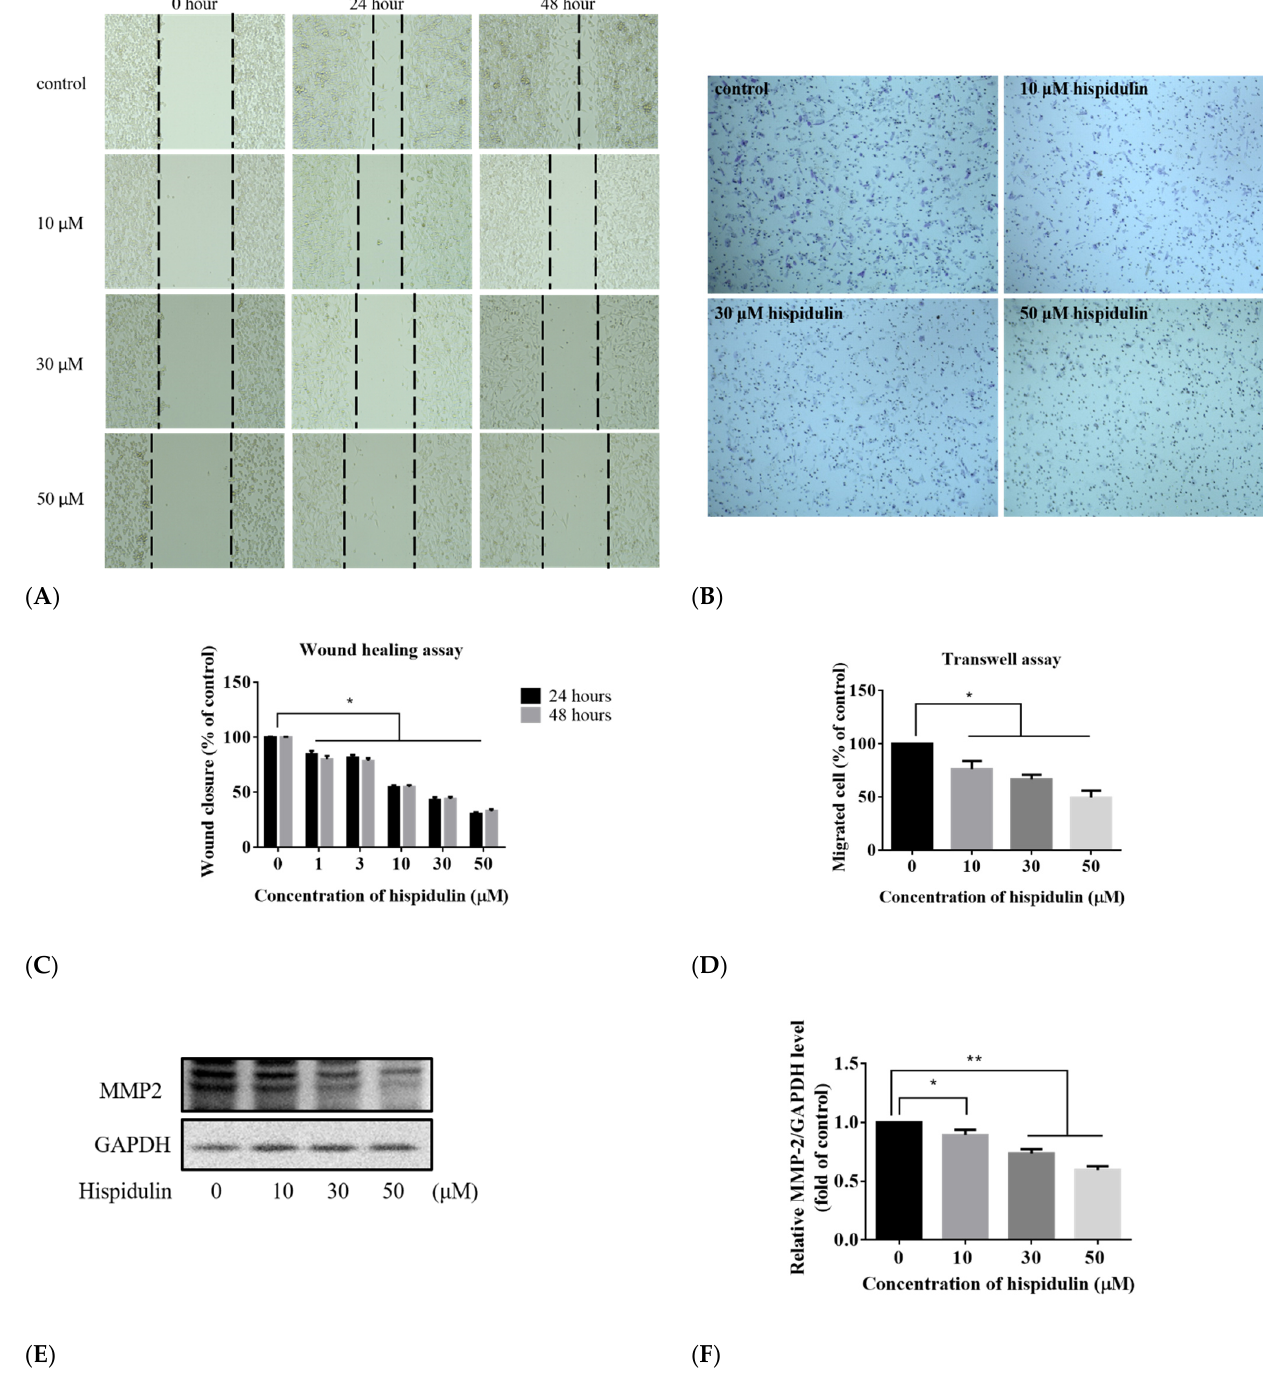
Figure 8. Hispidulin suppressed the motility of the A2058 cells through the wound healing assay and transwell assay ( A , B ). Cell mobility was determined by the wound healing assay. Monolayers of A2058 cells were treated with various concentrations of hispidulin for 24 and 48 h. Cell mobility was determined by the transwell chamber assay. A2058 cells were pretreated with different concentrations of hispidulin for 24 h then seeded in the upper chamber for 5 h. After incubation for 5 h at 37 °C, fixation was performed, and non-migrated cells were removed. A2058 cells that migrated to the underside of filter membrane were photographed and counted. ( C ) The quantitative assessment of the number of cells in the denuded zone. ( D ) A2058 cells that migrated to the underside of filter membrane were photographed and counted. ( E , F ) The expression levels of MMP-2 in A2058 cells treated with different concentrations (0, 10, 30, and 50 µM) of hispidulin for 24 h and examined by Western blot assay. Data were presented as fold of control and mean ± SE, with * p < 0.05 and ** p < 0.01 compared with the untreated control group (n = 5).